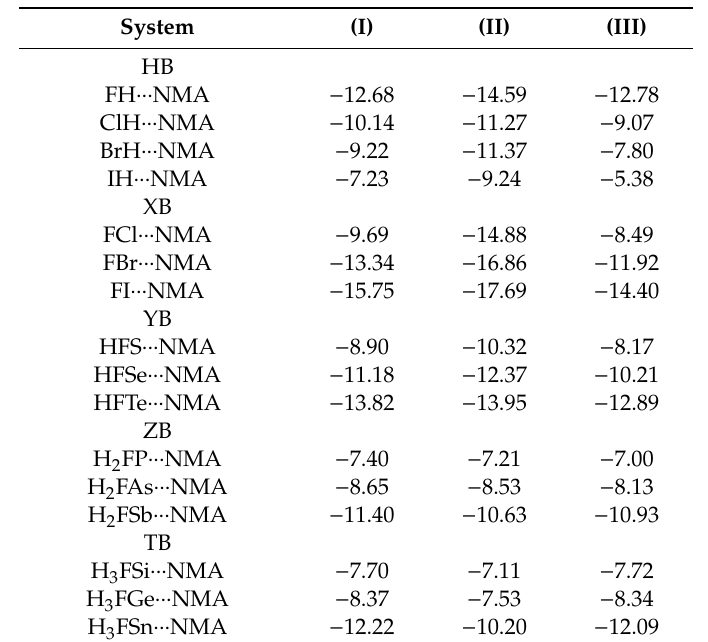
Table 4. Interaction energies (E int , kcal · mol − 1 ) corrected for basis set superposition error (BSSE) calculated at the MP2 / aug-cc-pVDZ (I), BLYP-D3 / Def2TZVPP (II), and CCSD(T) / aug-cc-pVDZ (III) levels of